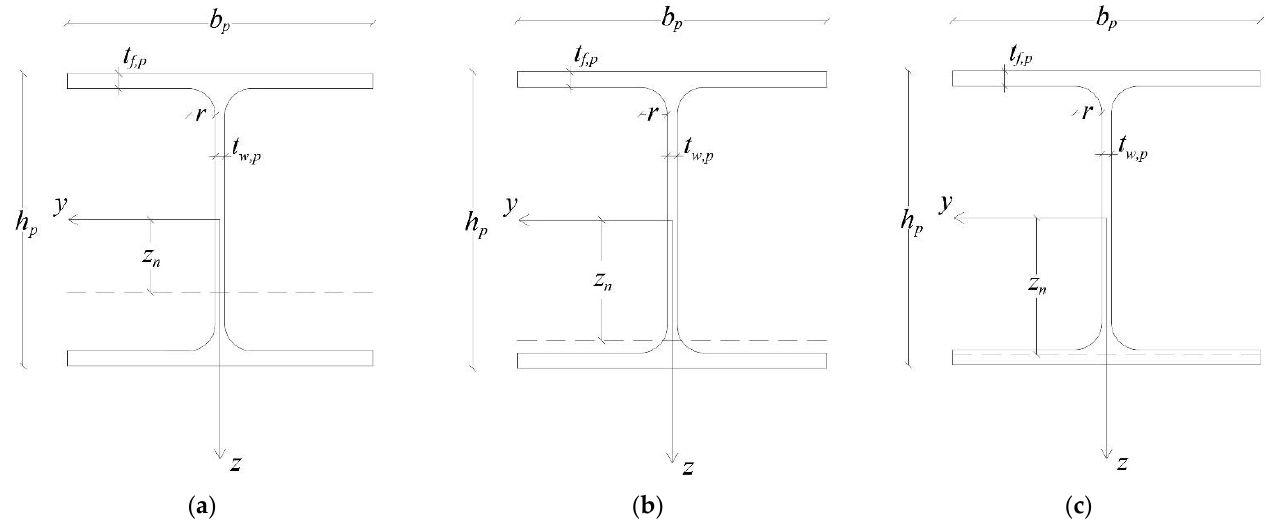
Figure 8. Standard profile geometry for yield domain: ( a ) neutral axis crossing the web; ( b ) neutral axis crossing the connection between web and flange; ( c ) neutral axis crossing the flange.